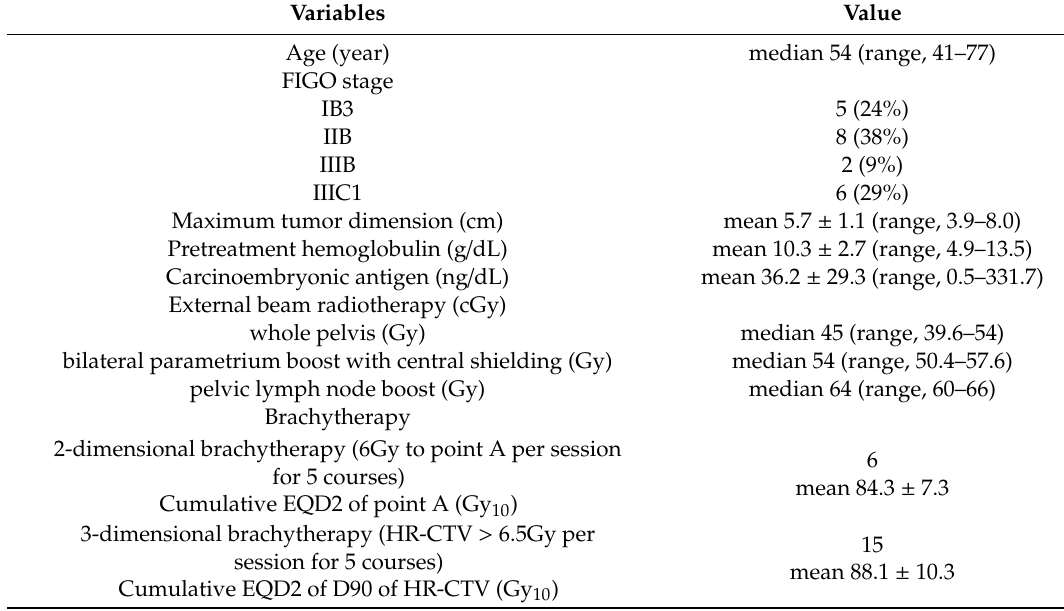
Table 3. Patient characteristics (N =